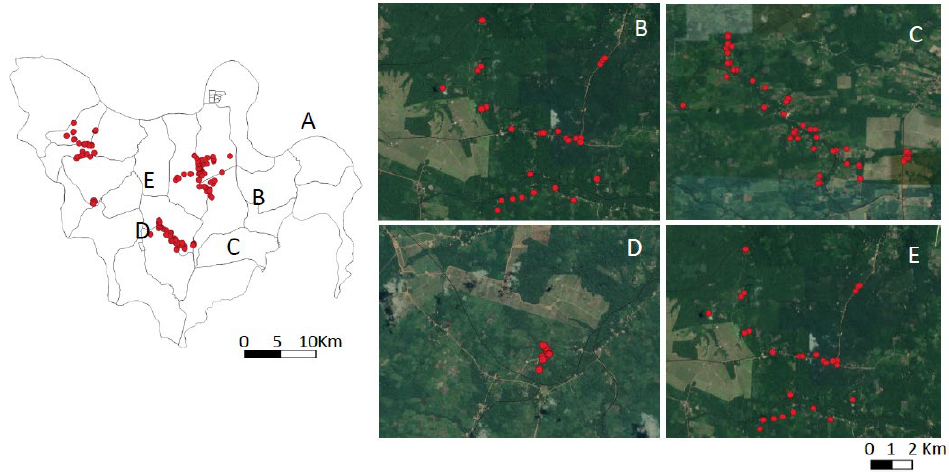
Figure 4. Spatial distribution of positive samples [human L. (L.) infantum chagasi -infections] in Bujaru (Pará State, Brazil) (2017–2018). Spatial resolution of the municipality ( A ) and community areas ( B – E ).